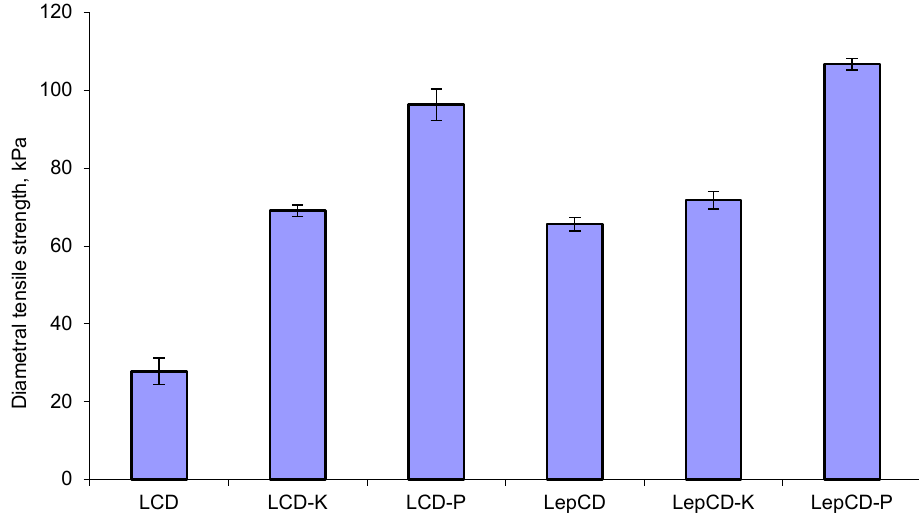
Figure 2. Diametral tensile strength of the studied material.